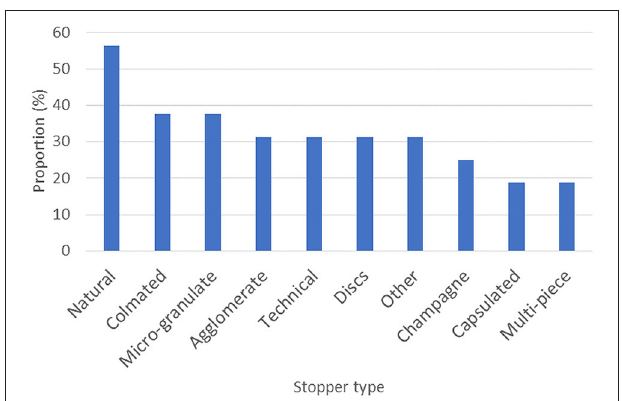
FIGURE 6 | Overview of types of cork stoppers produced by our